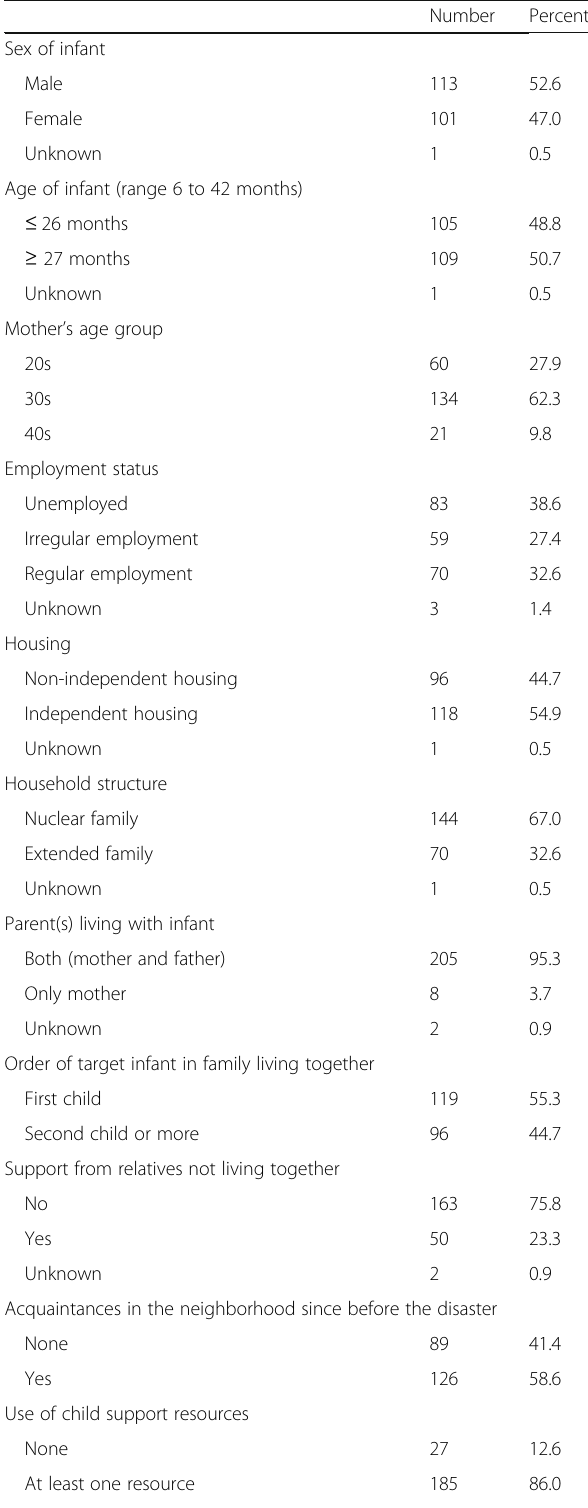
Table 1 Sociodemographic and socioenvironmental characteristics of mothers living in a house different from their house before the disaster ( n = 215)